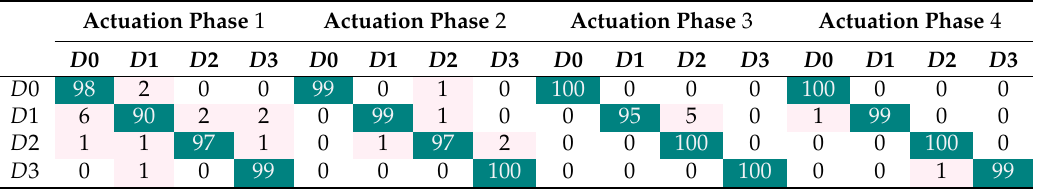
Table 5. Confusion matrix of the application of the t -SNE based damage detection and classification procedure presented in Sections 3 and 4 to the case of the aluminum plate in Scenario 3 , in the frequency domain . Rows represent true values, while columns represent predicted values.